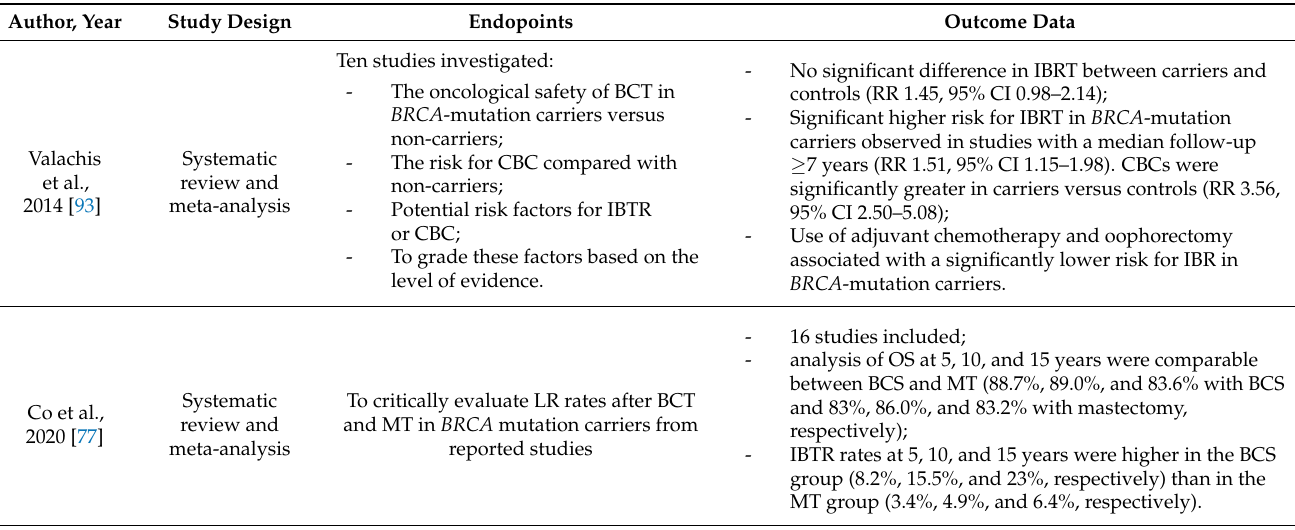
Table 2. Systematic review and meta-analysis